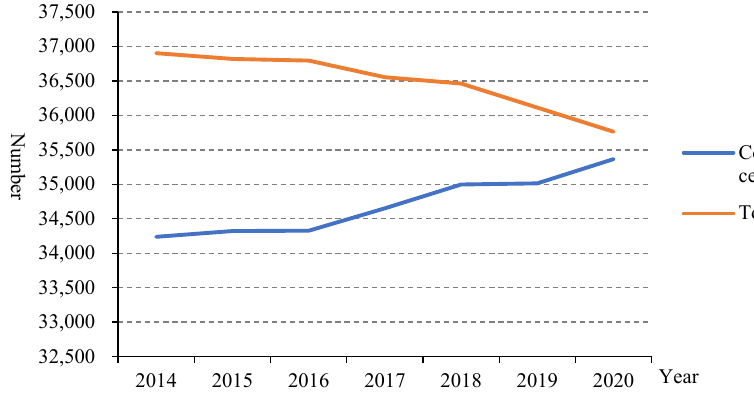
Figure 1. The number of PHIs in China from 2014 to 2020.